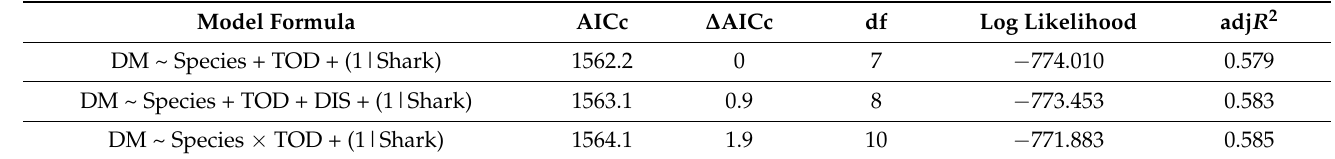
Table 2. Model selection results only include models with ∆ AIC < 2. DM represents median depth, TOD represents the category time of day, DIS represents day in season, and Shark represents an individual